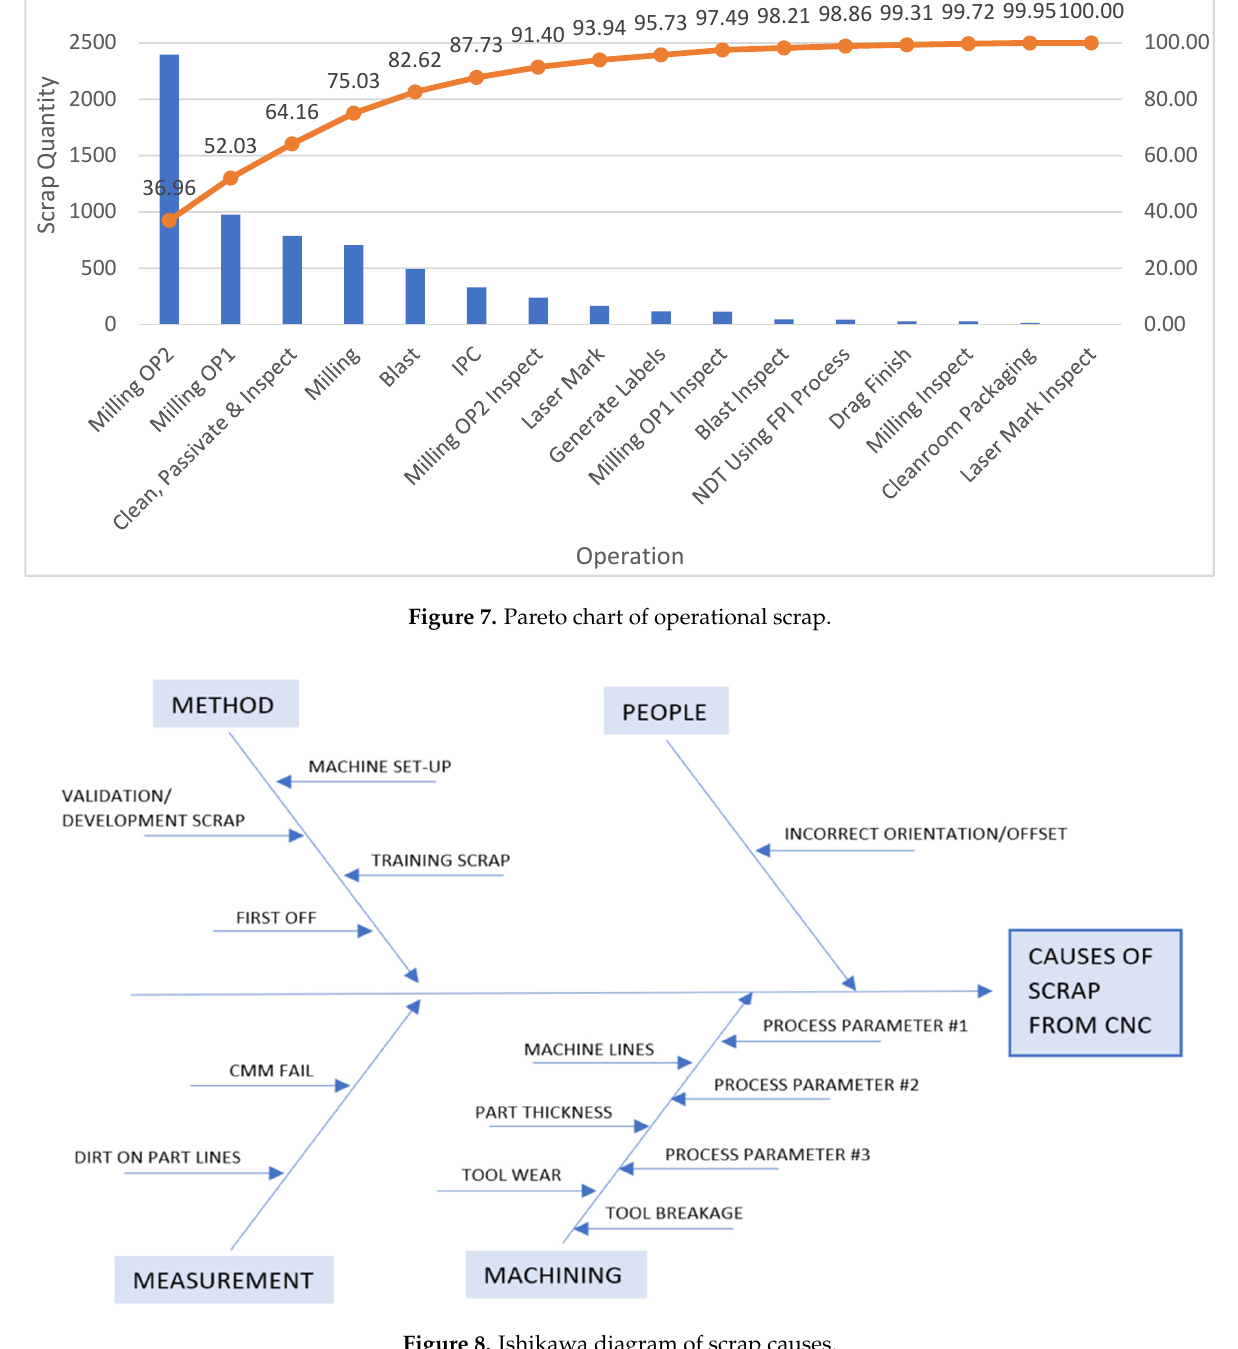
Figure 9. Pareto chart of causes of scrap in CNC–CMM.